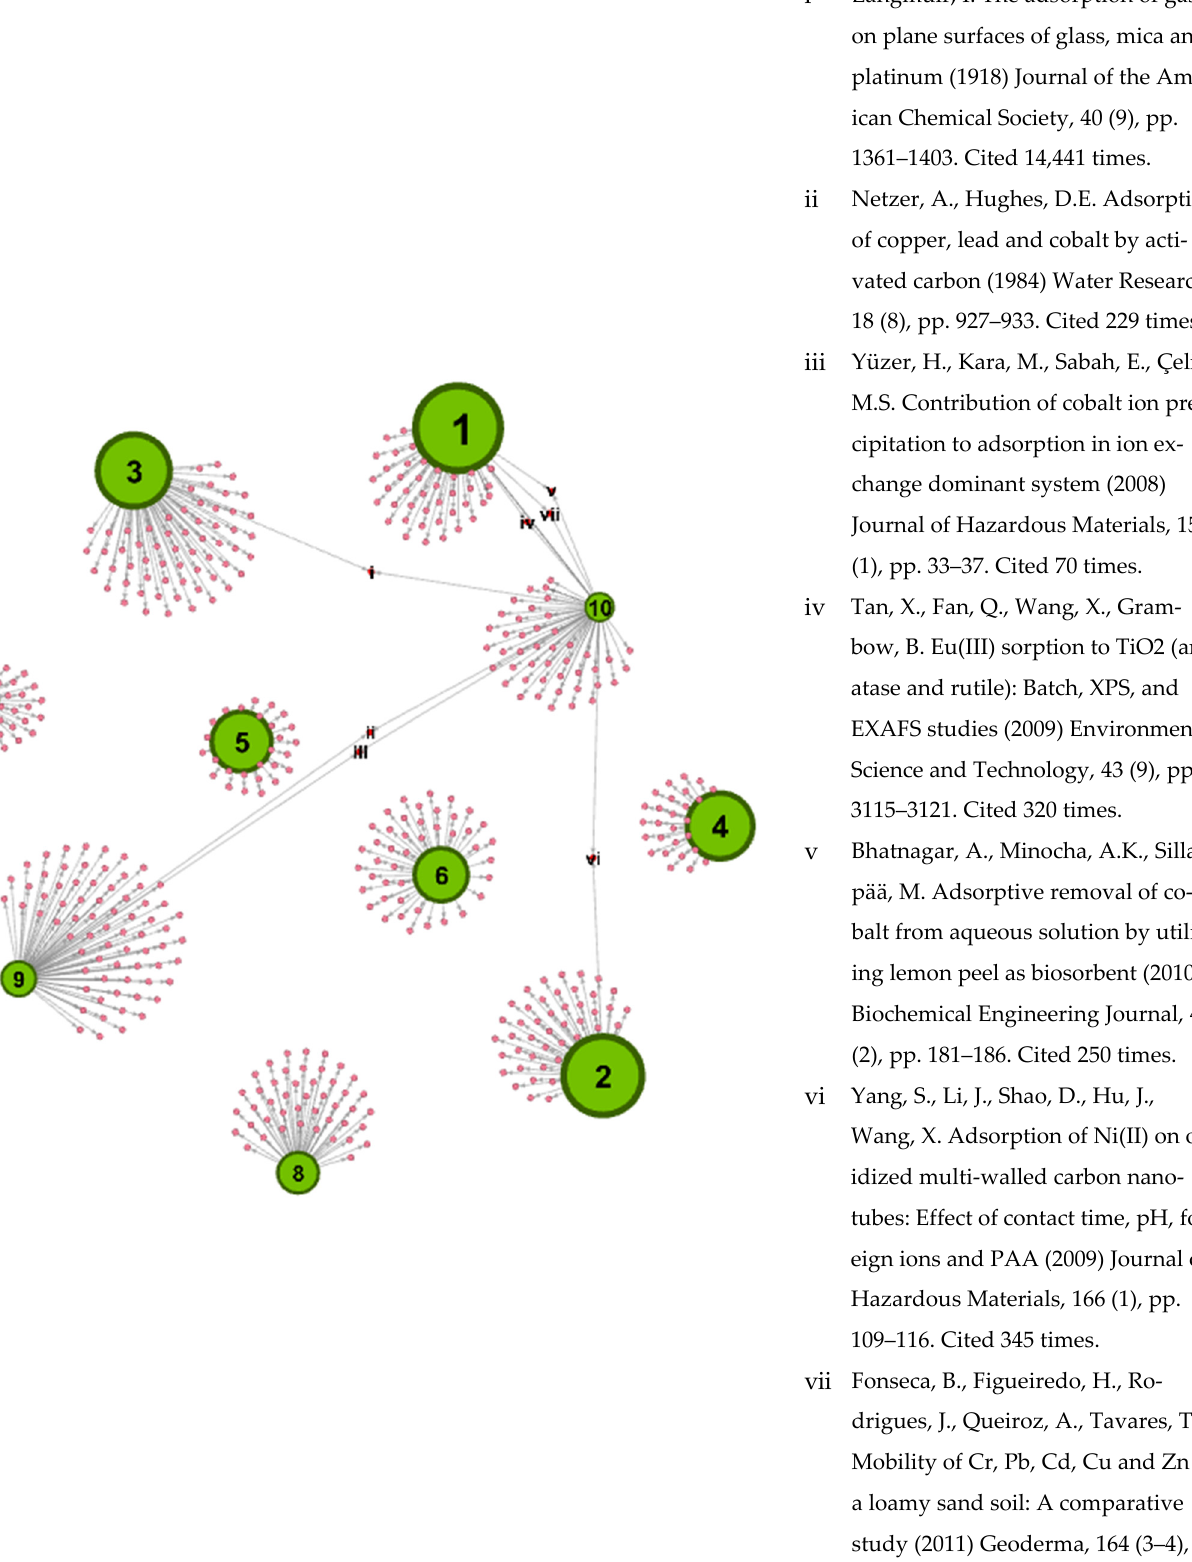
Figure 8. Citations’ network visualization and corresponding co-cited references of the top 10 cited publications.